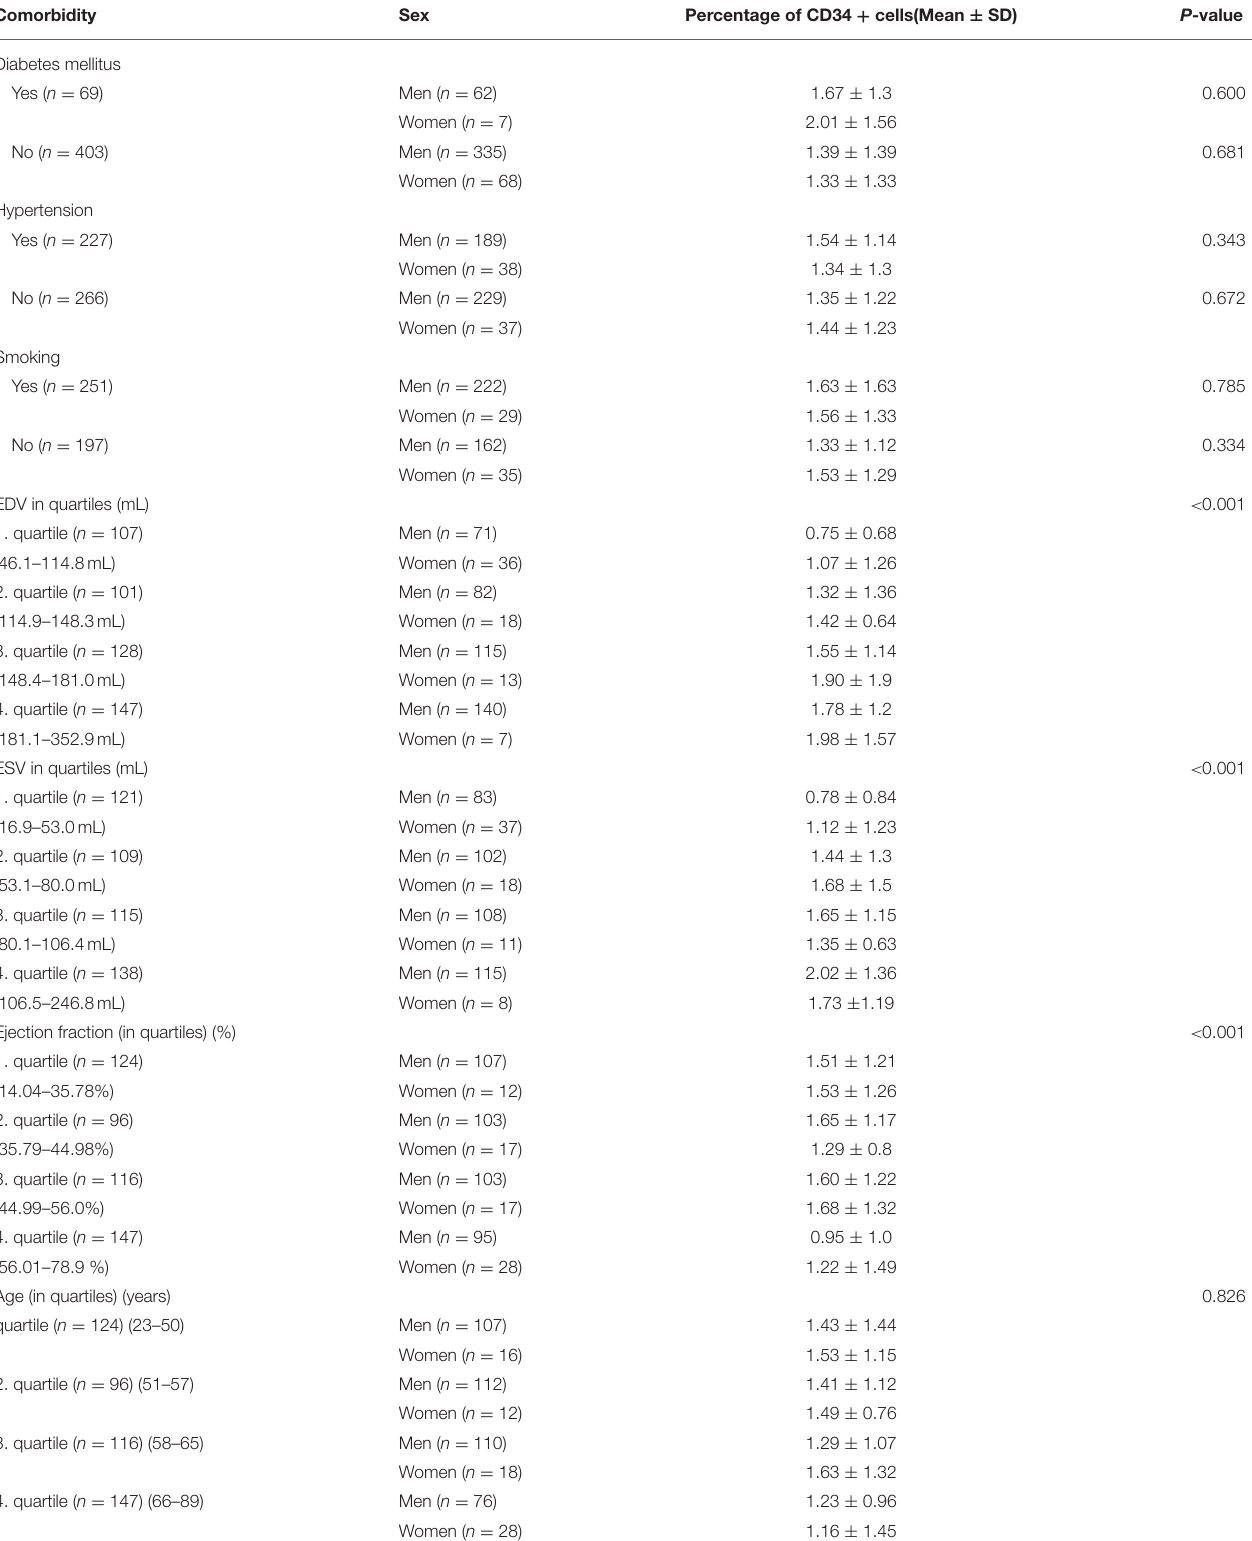
TABLE 6 | Percentage of CD34 + cells in women and men with different comorbidities. Comorbidity Sex Percentage of CD34 + cells(Mean ± SD) P -value Diabetes